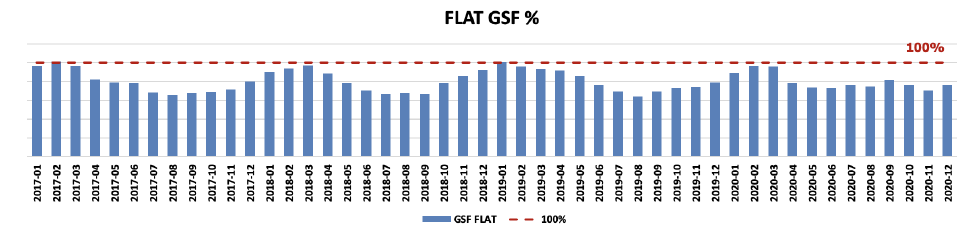
Figure 2. Historical Flat